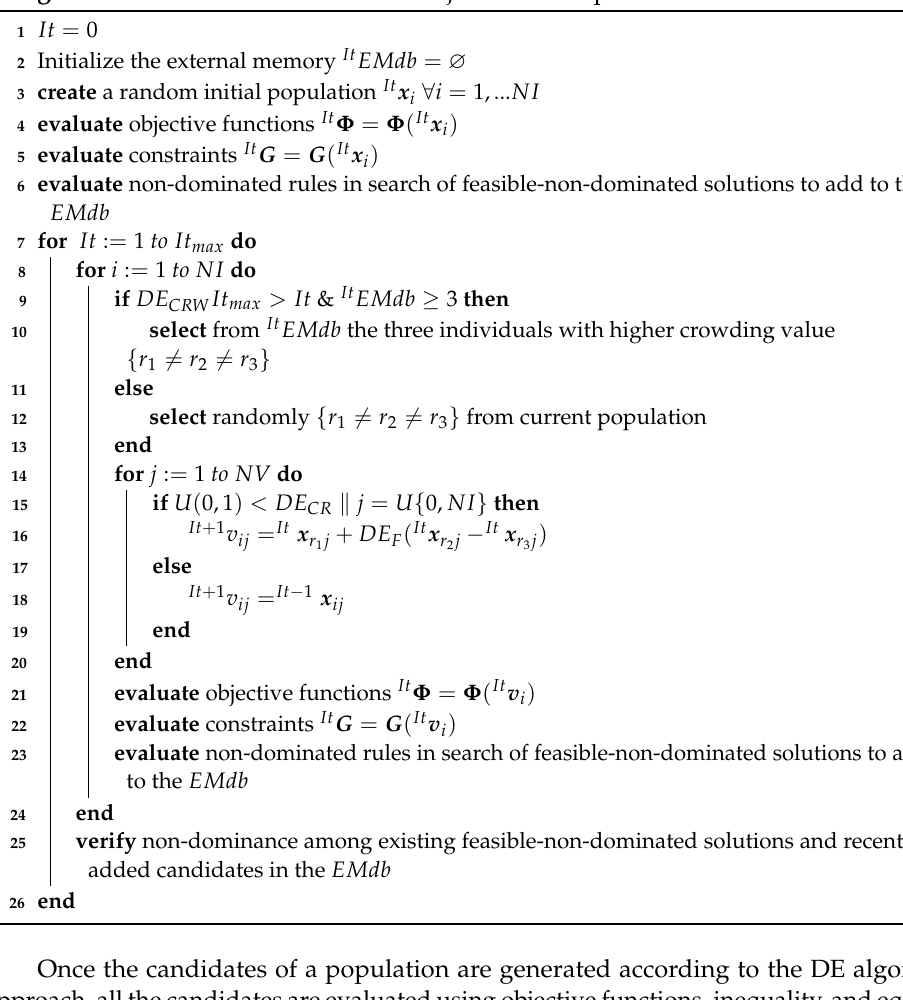
Algorithm 1: Pseudo code of a multi-objective DE